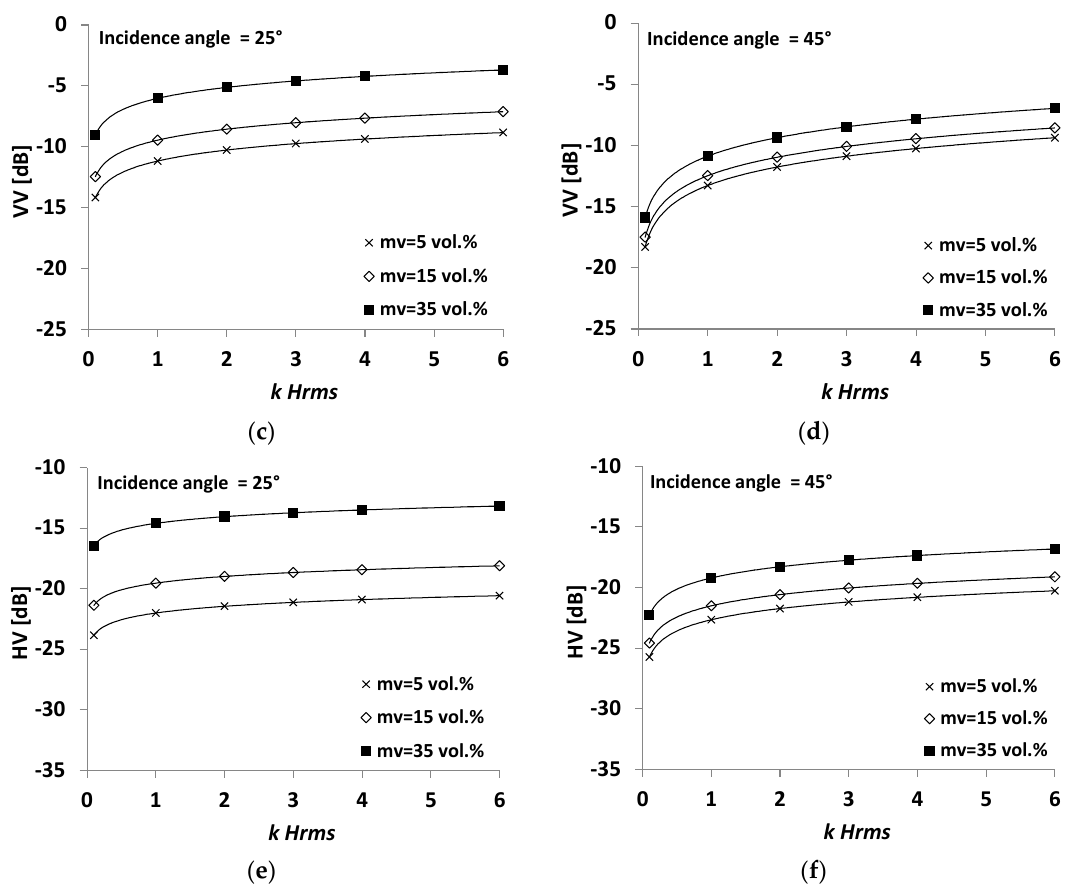
Figure 6. Behavior of the new model as a function of incidence angle ( θ ), surface roughness ( k Hrms ) and soil moisture ( mv ) in HH ( a and b ), VV ( c and d ), and HV ( e and f ) polarizations. ( a , c , e ): θ = 25 ◦ ; ( b , d , f ): θ = 45 ◦